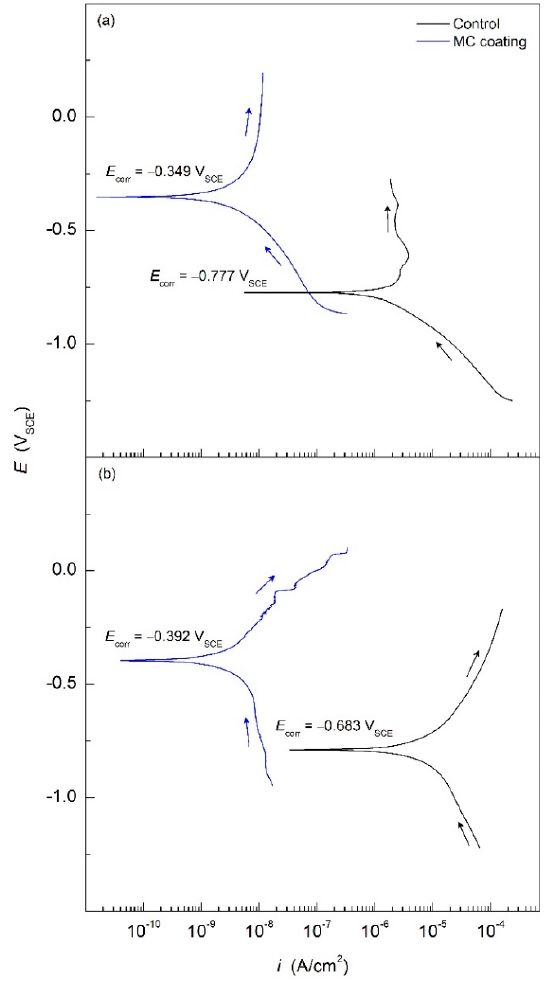
Figure 7. Potentiodynamic polarization curves for mild steel with epoxy coating modified with colophony microcapsules exposed to ( a ) simulated concrete pore solution, and ( b ) DI water contaminated with 3.5 wt.% NaCl. Table 2. Electrochemical parameters calculated by Tafel fitting from potentiodynamic polarization for epoxy coating containing microcapsules in simulated concrete pore solution (pH 12.6) and DI water (pH 6.8) contaminated with 3.5 wt.% NaCl.